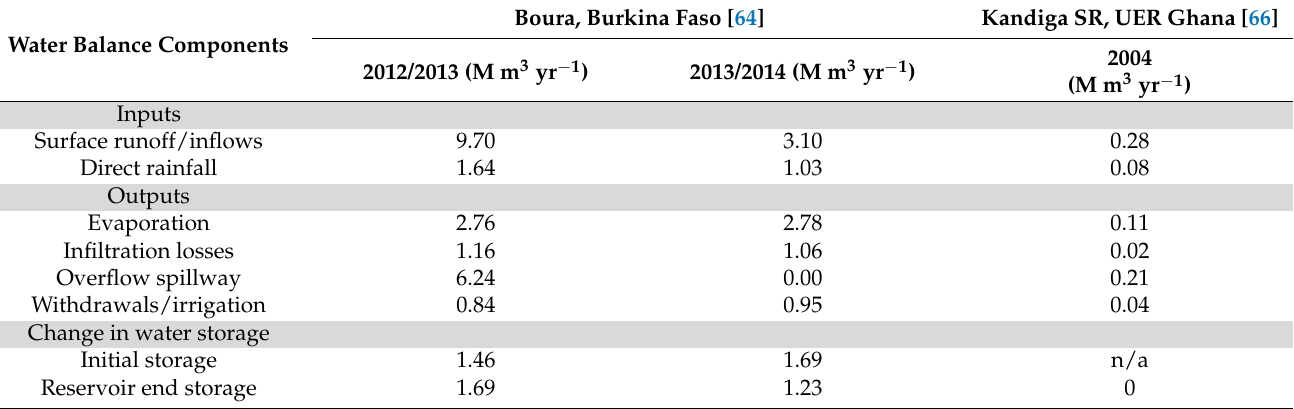
Table 7. Water fluxes in two small